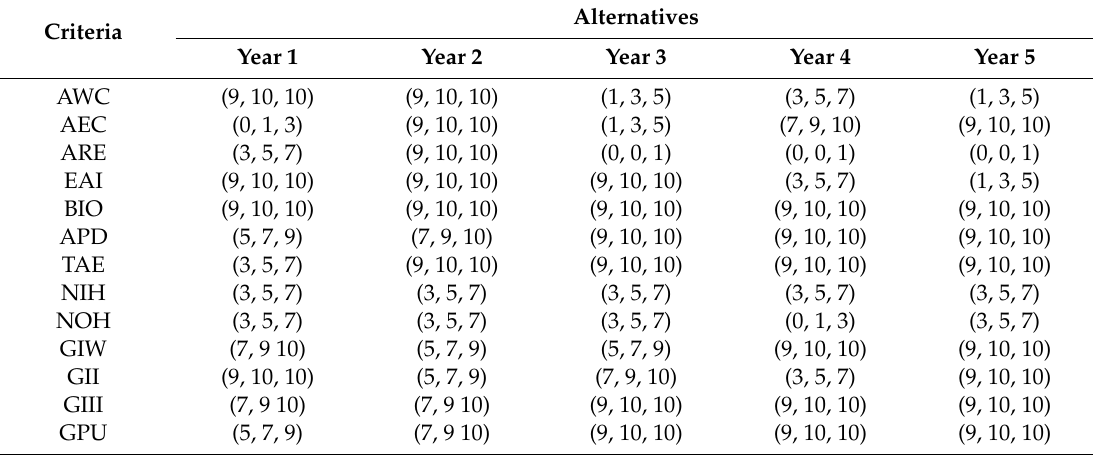
Table 3. Initial values of the fuzzy multicriteria decision-making matrix corresponding to the assessment of each alternative (year) in each criterion / subcriterion by the